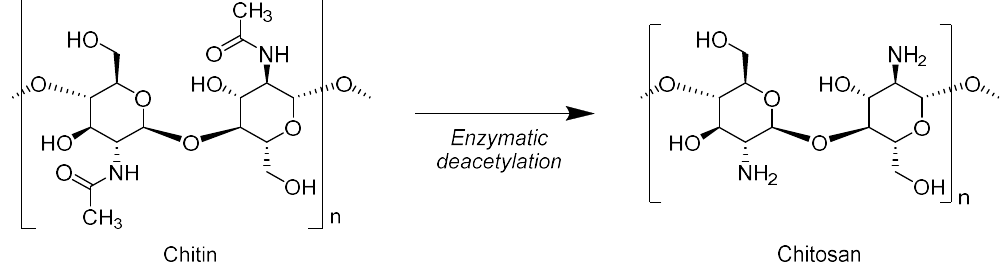
Figure 10. Enzymatic deacetylation of chitin to chitosan.